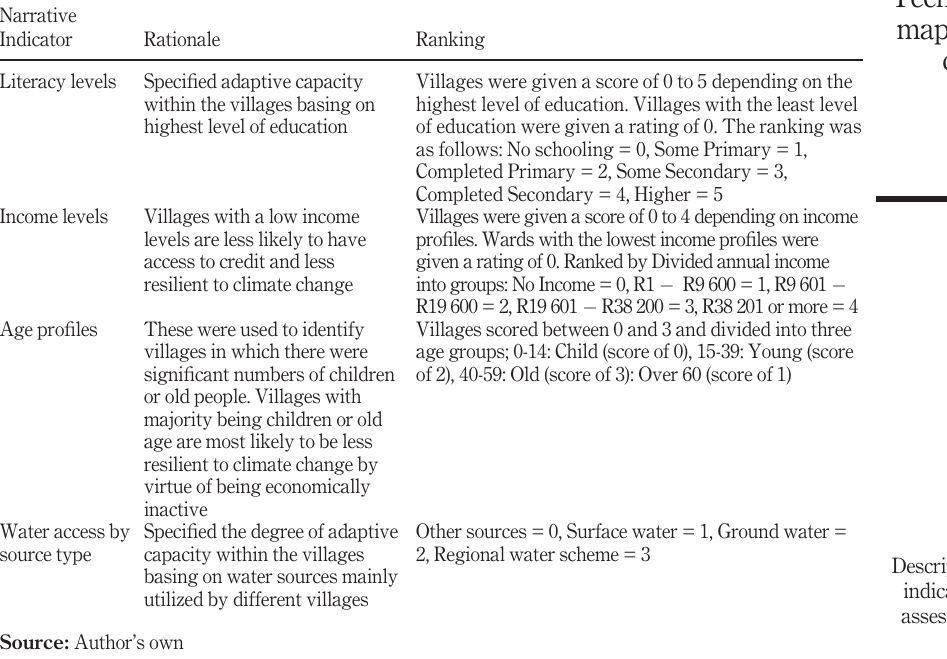
Table I. Description of input indicators used for assessing